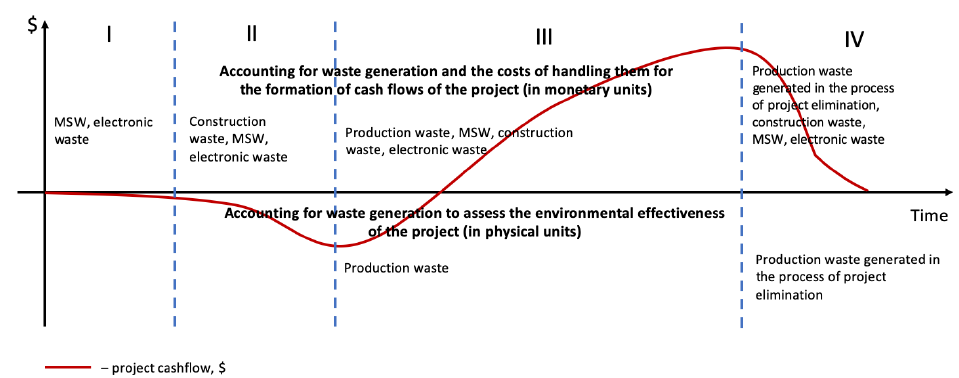
Figure 3. A potential scheme for accounting for waste generation in the formation of cash flows and conducting an environmental assessment of an investment project in the energy